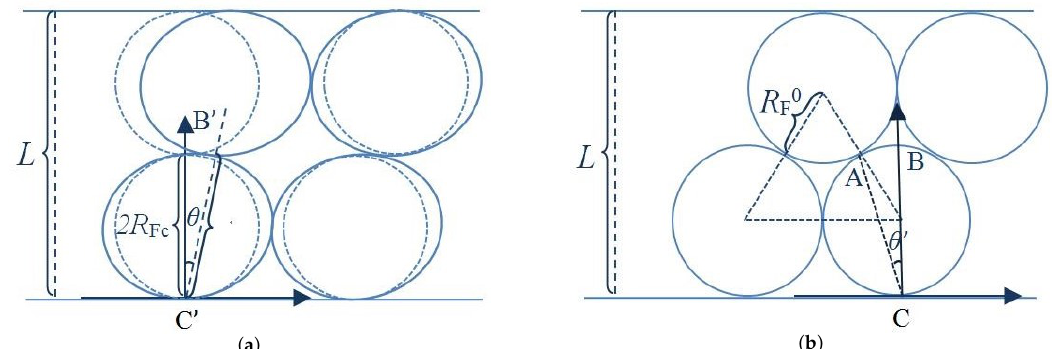
Figure 3. Sketch for an estimation of the yielding shear strain: ( a ) before elongation; ( b ) at critical